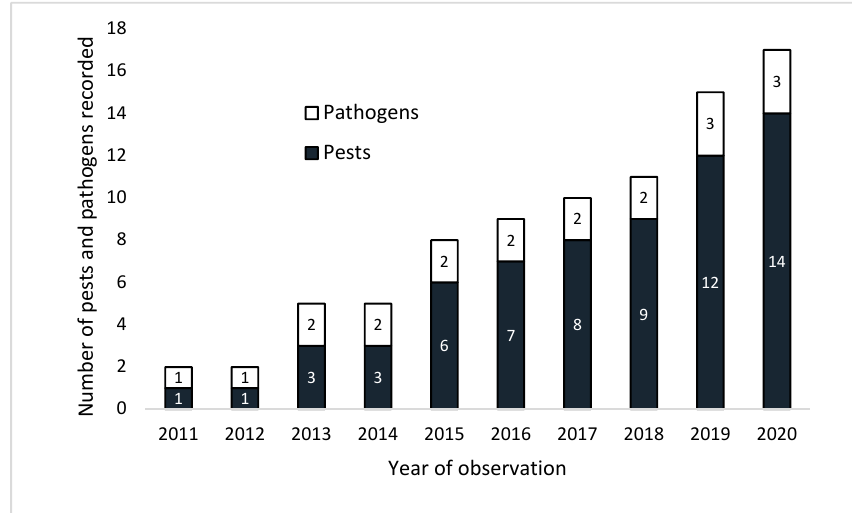
Figure 2. Change in the number of pest and pathogen species recorded each year. Table 3. Temporal and geographical occurrence of pest and pathogen species in forest health surveys in Vietnam from